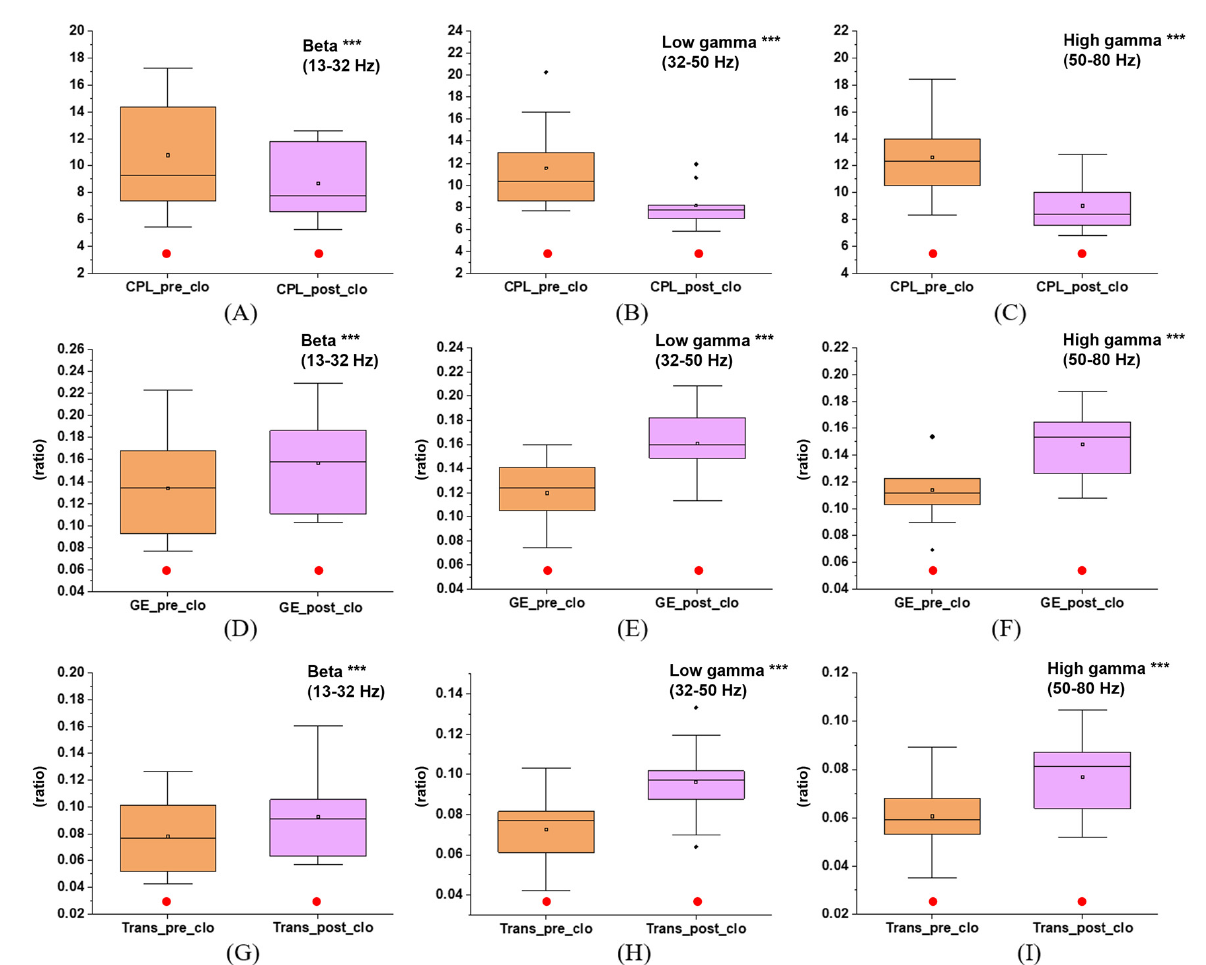
Figure 7. CPL, GE, and transitivity variation in stages two and five at different frequency bands: ( A ) CPL in the beta band ( p = 0.046); ( B ) CPL in the low gamma band ( p = 0.009); ( C ) CPL in the high gamma band ( p = 0.002); ( D ) GE in the beta band ( p = 0.035); ( E ) GE in the low gamma band ( p = 0.003); ( F ) GE in the high gamma band ( p = 0.002); ( G ) Transitivity in the beta band ( p = 0.038); ( H ) Transitivity in the low gamma band ( p = 0.002); ( I ) Transitivity in the high gamma band ( p = 0.007). *** indicates that the difference in the diagram is significant ( p < 0.05) in the paired–samples t –test. The solid red circle indicates no gender difference for this parameter.